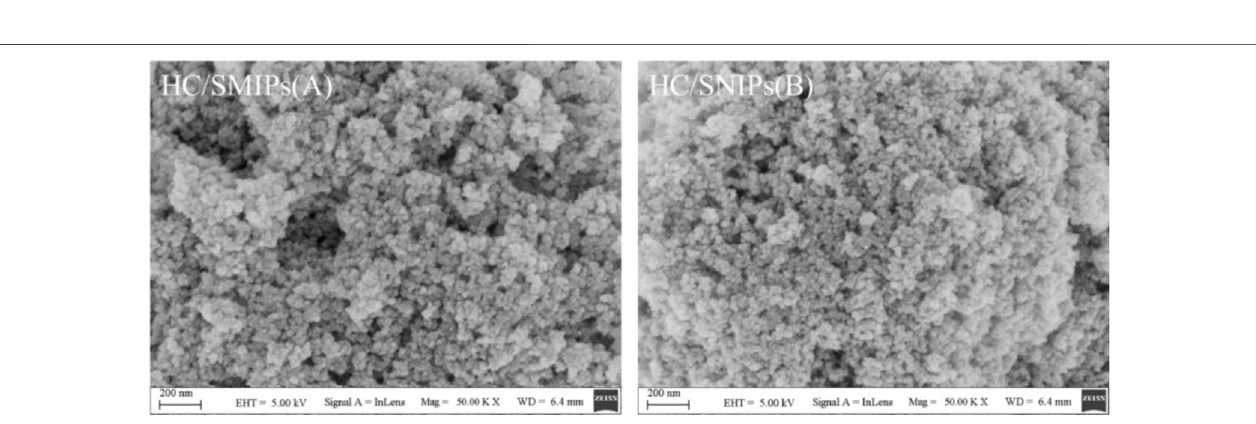
Frontiers in Chemistry |